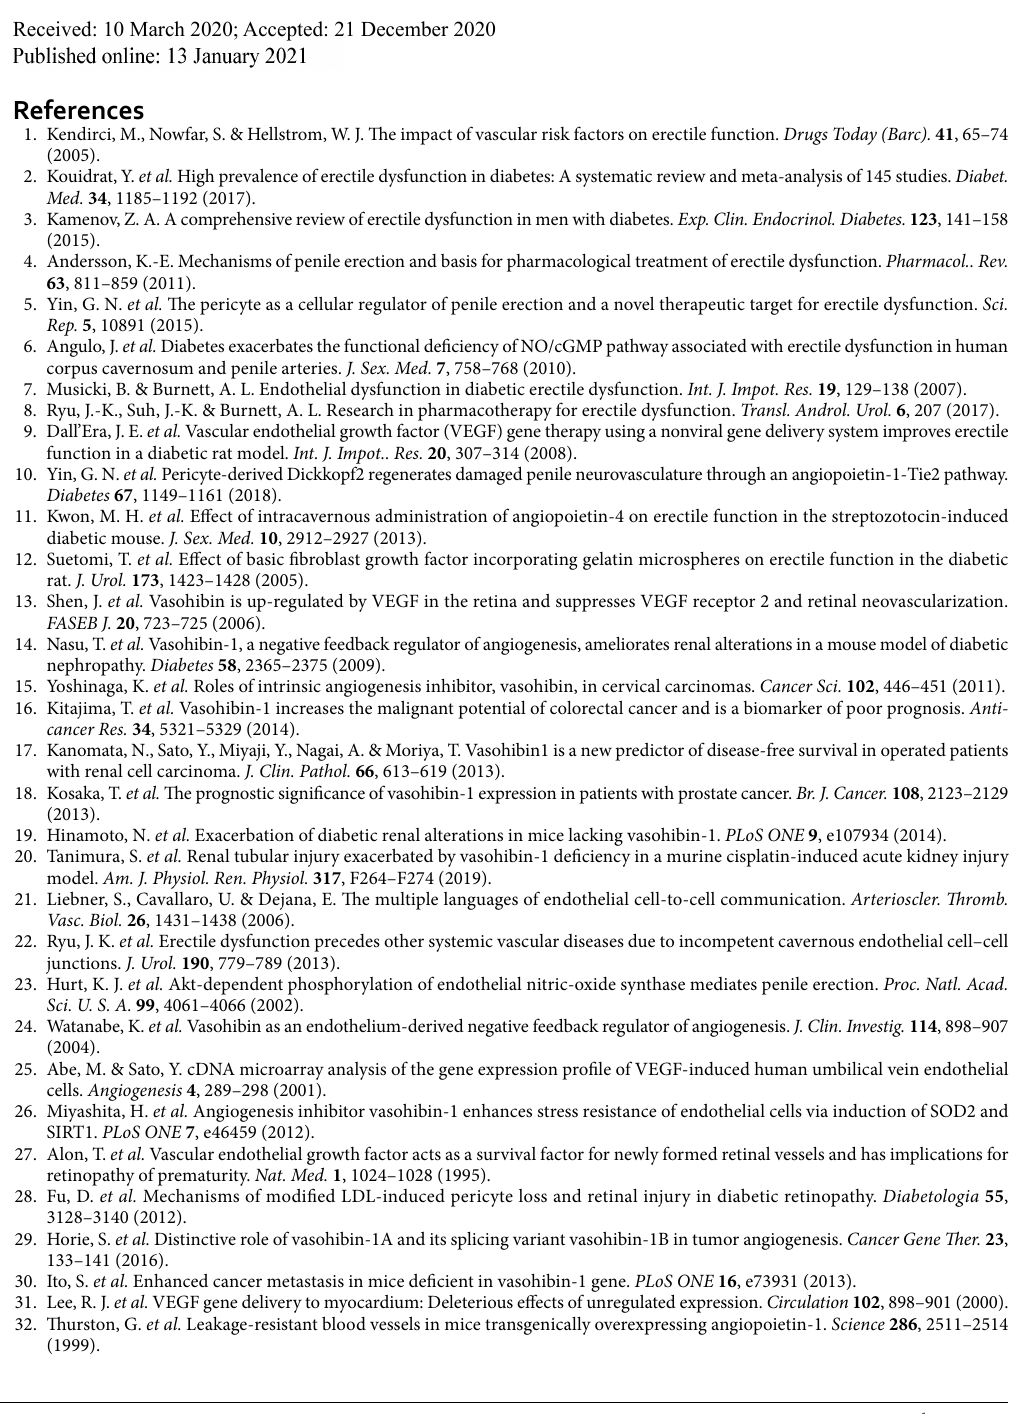
Figure 7. Inhibition of Ang1 and VEGF diminishes VASH1 protein-mediated angiogenesis and recovery of erectile function in the diabetic mice. ( a ) Representative intracavernous (ICP) responses for the age-matched control and streptozotocin-induced diabetic mice stimulated at 2 weeks after repeated intracavernous injections of PBS + dimeric Fc (day − 3 and 0), VASH1 protein (day − 3 and 0; 4 μg/20 μL), VASH1 protein + soluble Tie2-Fc(sTie2-Fc; 4 μg/20 μL), or VASH1 protein + VEGF trap (4 mg/kg in 20 µL PBS). The stimulus interval is indicated by a solid bar. ( b , c ) Ratios of mean maximal ICP and total ICP (area under the curve) to mean systolic blood pressure (MSBP) were calculated for each group. Each bar depicts the mean (± SE) values from N = 6 animals per group. ** P < 0.01 vs. control group. # P < 0.05 and ## P < 0.01 vs. PBS- + dimeric Fc-treated group. † P < 0.05, †† P < 0.01, and ††† P < 0.001 vs. VASH1-treated DM group. ( d ) PECAM-1 (red) and NG2 (green) staining in cavernous tissue from each group of animals. Scale bar = 100 µm. ( e , f ) Quantification of cavernous endothelial cell and pericyte content by Image J. Each bar depicts the mean (± SE) values from N = 6 animals per group. *** P < 0.001 vs. control group. ### P < 0.001 vs. PBS- + dimeric Fc-treated group. ††† P < 0.001 vs. VASH1 treated DM group. DM diabetes